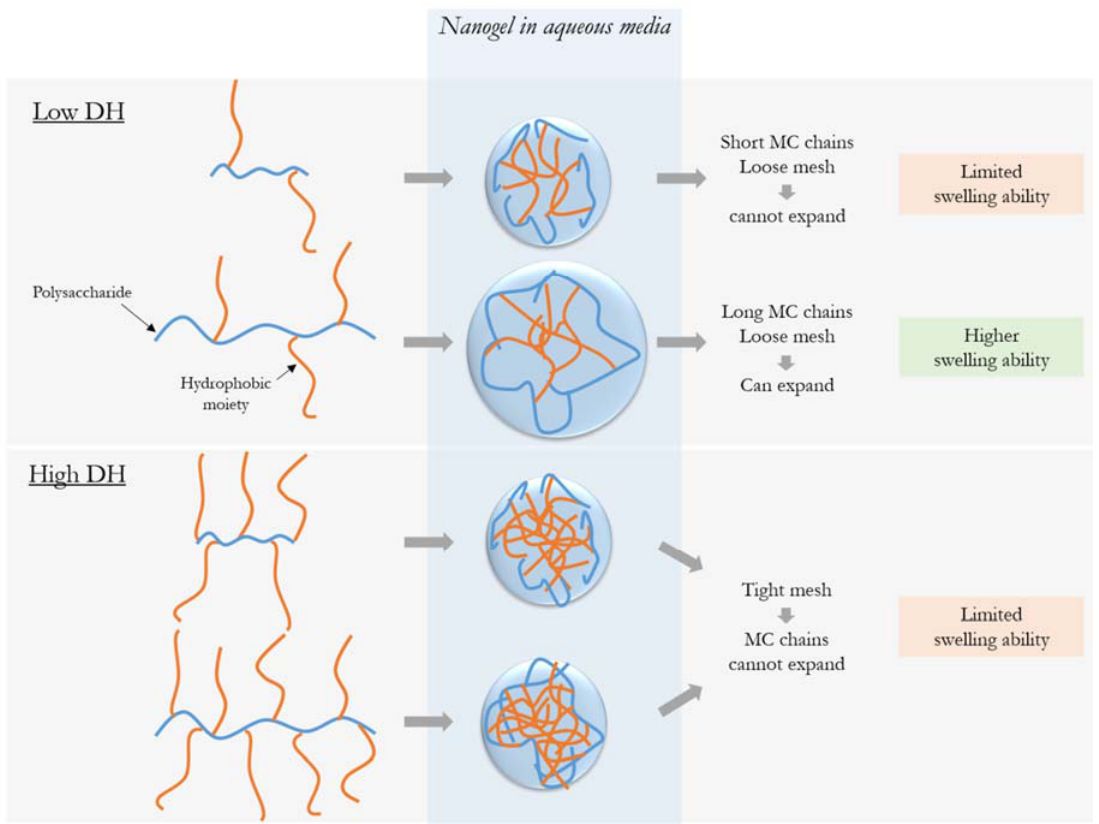
Figure 2. Scheme to illustrate the influence of MC molecular on the swelling ability of the nanogel (simplified with a single hydrophobic domain) at both degrees of hydrophobization. At high levels of hydrophobic modification, the tight mesh of the aggregates is unable to swell. Low levels of hydrophobic grafting create aggregates with a looser mesh, in which only longer MC chains can expand to take up water while maintaining the cohesion of the nanogel.